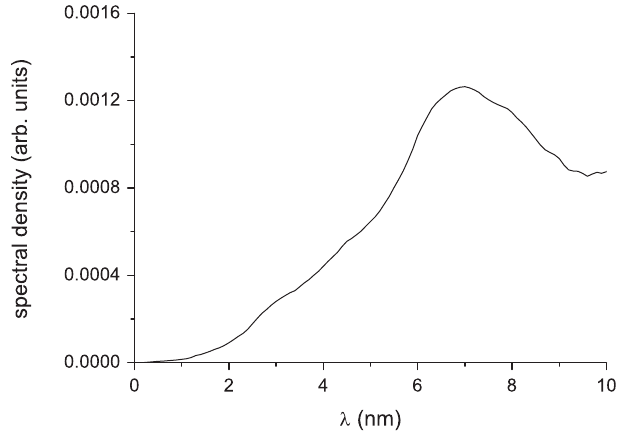
FIG. 10. Ensemble-averaged spectrum of the electron current (modulus of the bunch form factor) after the last chicane. The calculations were performed with LOSCA .